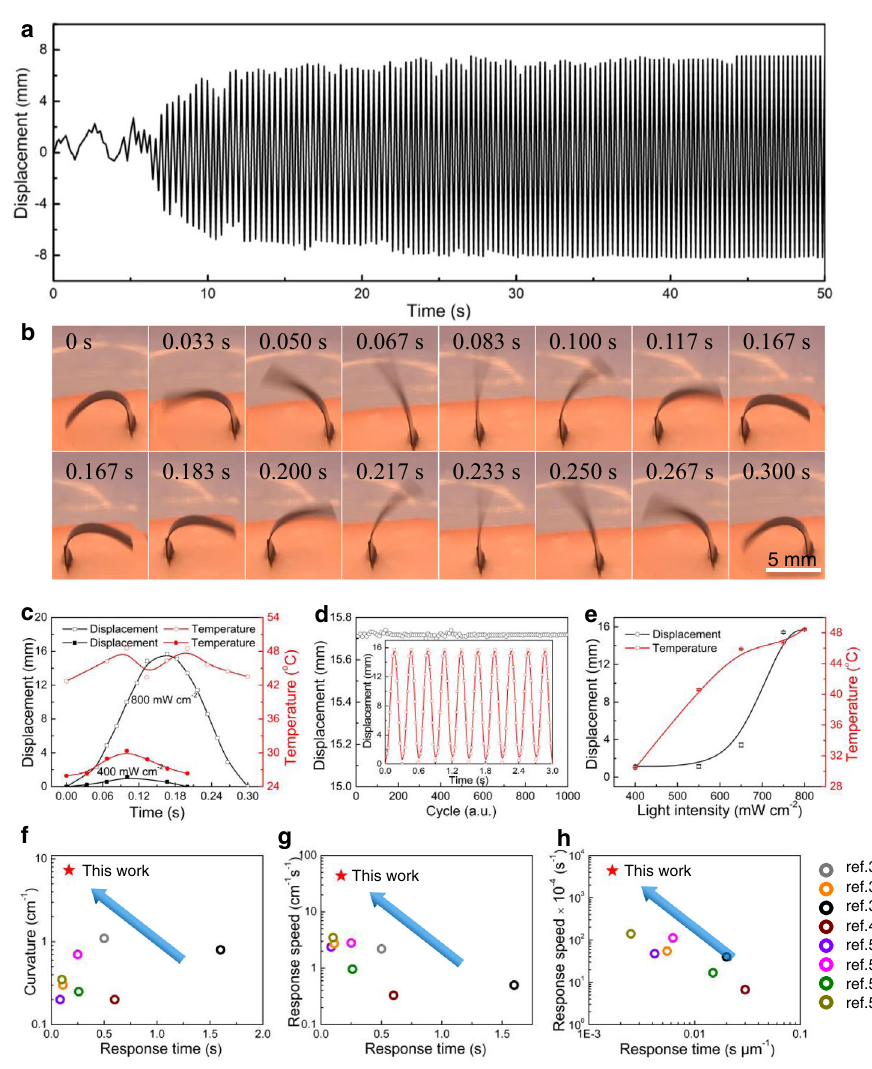
Fig. 3 | Actuation performances of the PP/CB actuator under NIR light. a Displacementasafunctionoftimeduringtheoscillatingactuationfortheporous PP/CB fi lm (9mm × 3mm × 100 μ m) with continuous ethanol supply under 800mWcm − 2 infrared light. b Photographs of the oscillating actuation under 800mWcm − 2 infrared light. c Displacement and temperatureasa function of time